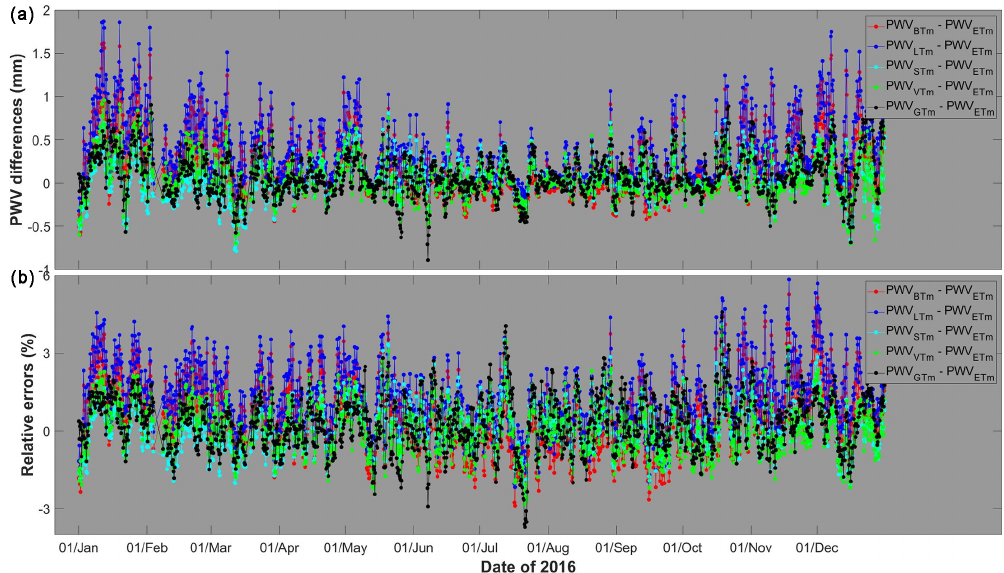
Figure 12. (a) PWV differences and (b) relative differences of PWV BTm , PWV LTm , PWV STm , PWV VTM and PWV GTm compared with PWV ETm at the ALIC station in the year 2016. PWV unit is